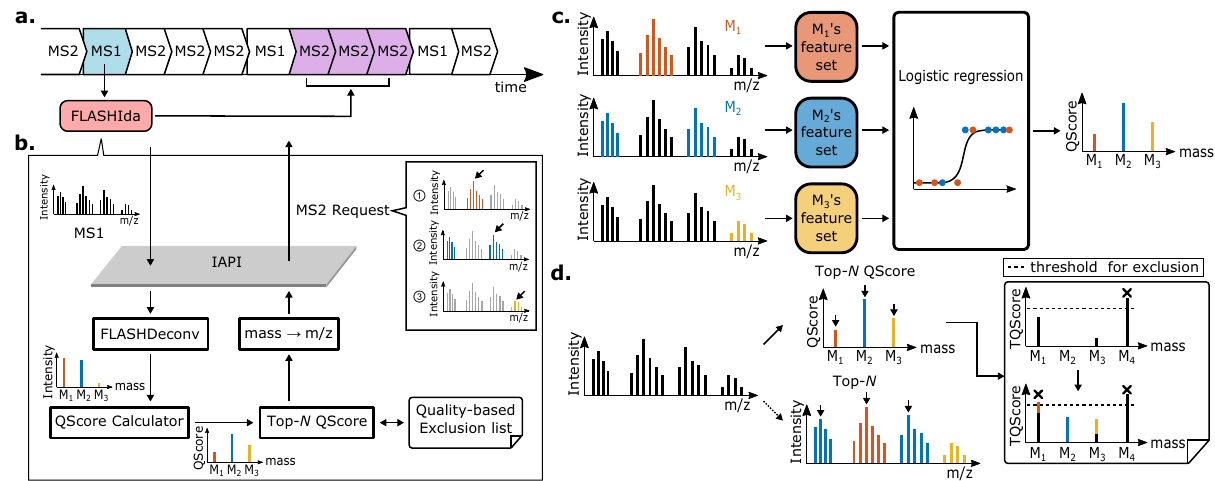
Fig. 1 Overview of FLASHIda. a MS duty cycle control employed by FLASHIda. FLASHIda processes each MS full scan within a few milliseconds (about 20 ms on average) and optimizes the acquisition of the next cycle. b Key steps of FLASHIda. FLASHIda uses Thermo iAPI to access MS full scan in real- time. FLASHIda takes three steps to select high quality precursor isotopomer envelopes of diverse proteoforms. The fi rst step is to transform the input m/ z-intensity spectrum into a mass-quality (QScore) spectrum, and the second is to select precursors in the transformed spectrum so that the number of unique proteoform level identi fi cations (simply proteoform ID) is maximized (Top- N QScore precursor acquisition with a quality-based exclusion list). Lastly, the charge state and isolation window size for each selected mass are dynamically determined to minimize interference from noise or coelution. The determined isolation window m/z ranges are provided to the instrument through the Thermo iAPI interface. c QScore calculation via logistic regression. After the deconvolution, the quality of the resulting fragmentation is measured for each precursor using a logistic regression with six features (see Methods). The features are extracted from the peaks in the original spectrum corresponding to the precursor. The quality metric, or QScore, is